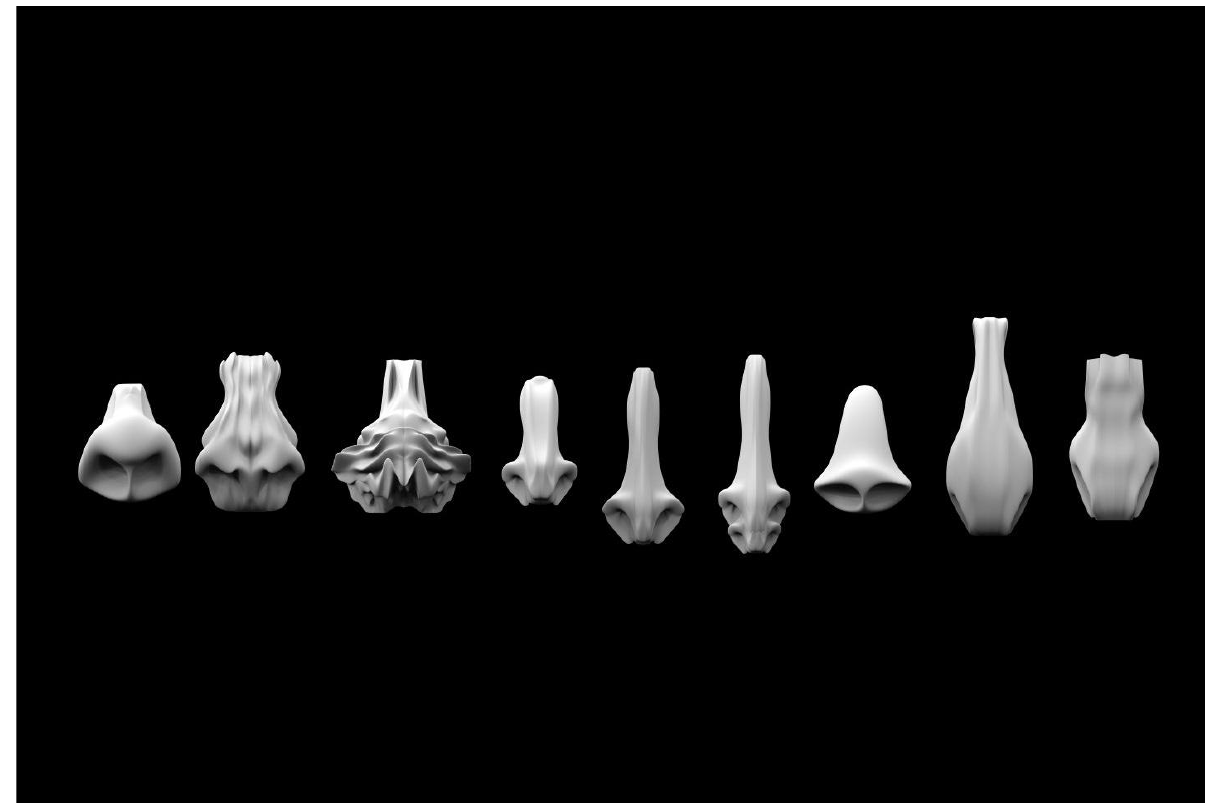
Figure 2 | Noses - different versions taken into